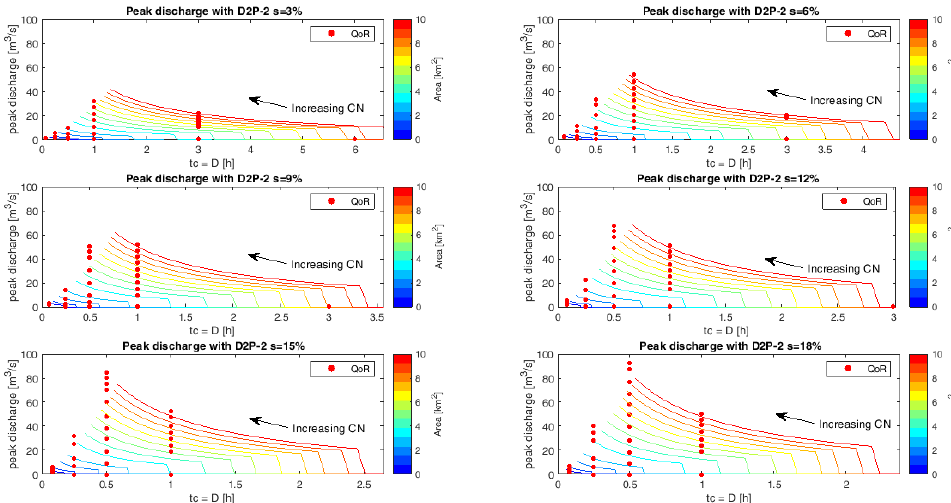
Figure 7. Peak curves obtained with D2P-2 vs. Q-Peak (red dots) evaluated with observed Rainfall.